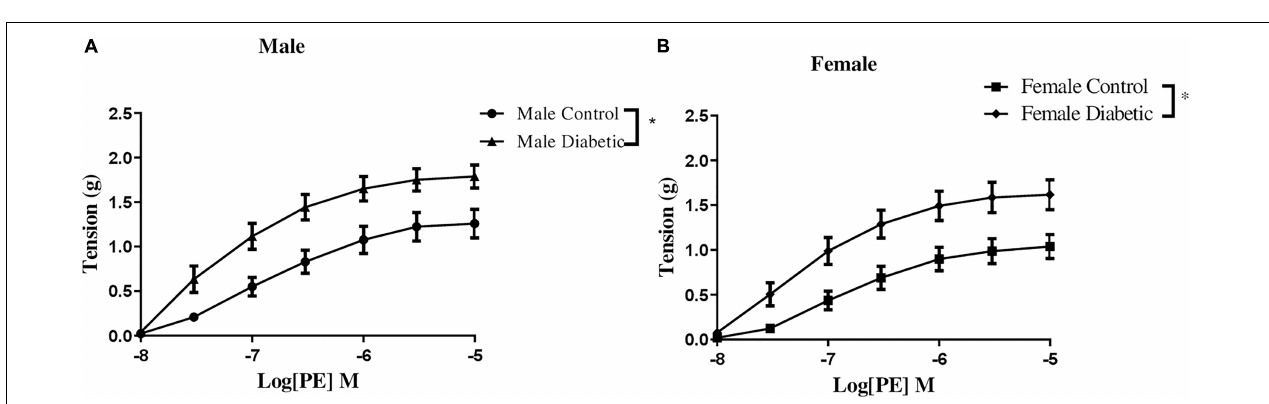
FIGURE 5 | Concentration-response curves to phenylephrine (PE) in control and UCD-T2DM rat aorta. Contractile responses to cumulative concentrations of PE (10 − 8 to 10 − 5 M) in intact aortic rings of (A) male and (B) female control and diabetic rats. Data are expressed as mean ± SEM. n = 5–6 per group. * p < 0.05 between two groups analyzed using two-way ANOVA followed by Bonferroni’s post hoc